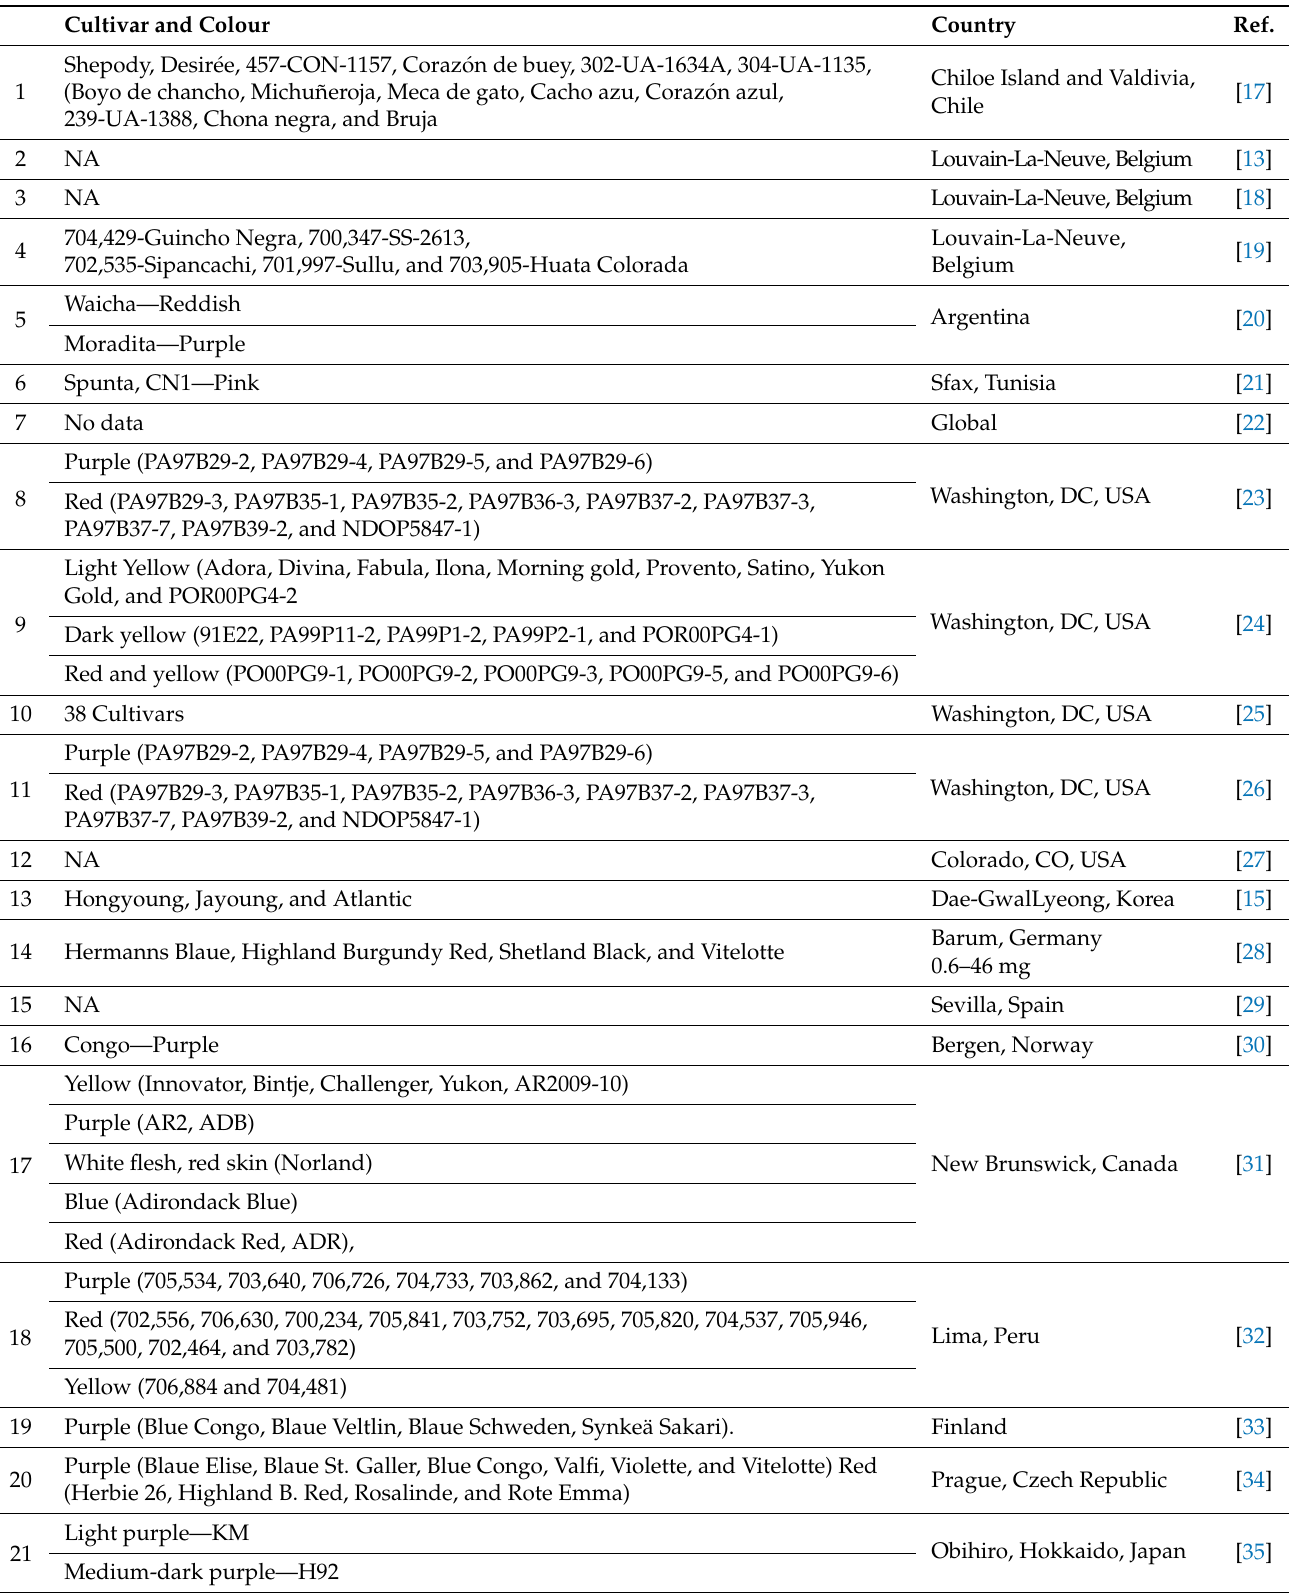
Table 1. Distribution of pigmented potato cultivars in various regions of the